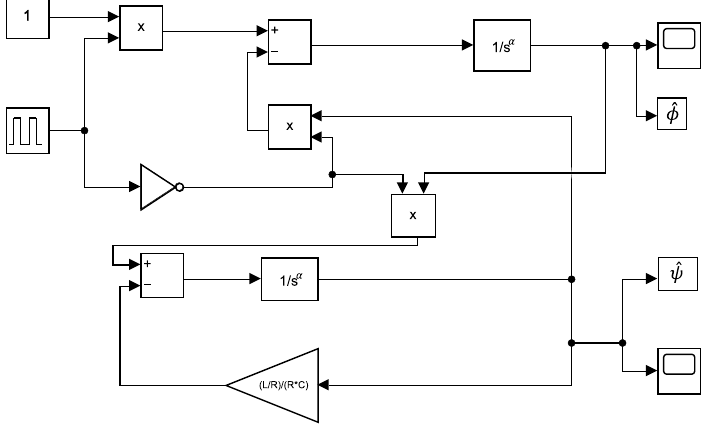
Figure 5. Numerical simulation of the fractional mathematical model by Matlab/Simulink. The parameters for this numerical simulation were previously given in Table 1.